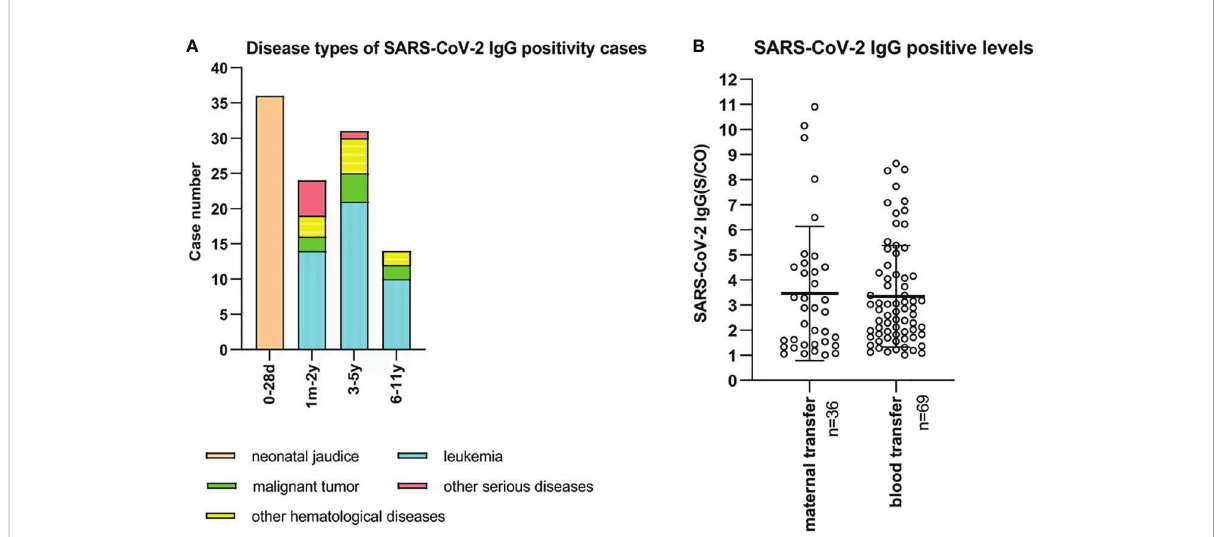
FIGURE 5 (A) Disease types of 105 SARS-CoV-2 IgG positive unvaccinated cases. X-bar represents age, and Y-bar represents the number of cases. 36 neonates were diagnosed with neonatal jaundice. 45, 10, 8, and 6 cases were diagnosed with leukemia, other hematological diseases, malignant tumors, and other serious diseases, respectively. (B) SARS-CoV-2 IgG-positive levels of 105 unvaccinated children. Maternal IgG antibody was transferred in 36 cases who were aged 0 to 28 days. Blood products were infused into 69 cases who were aged 1 month to 11 years